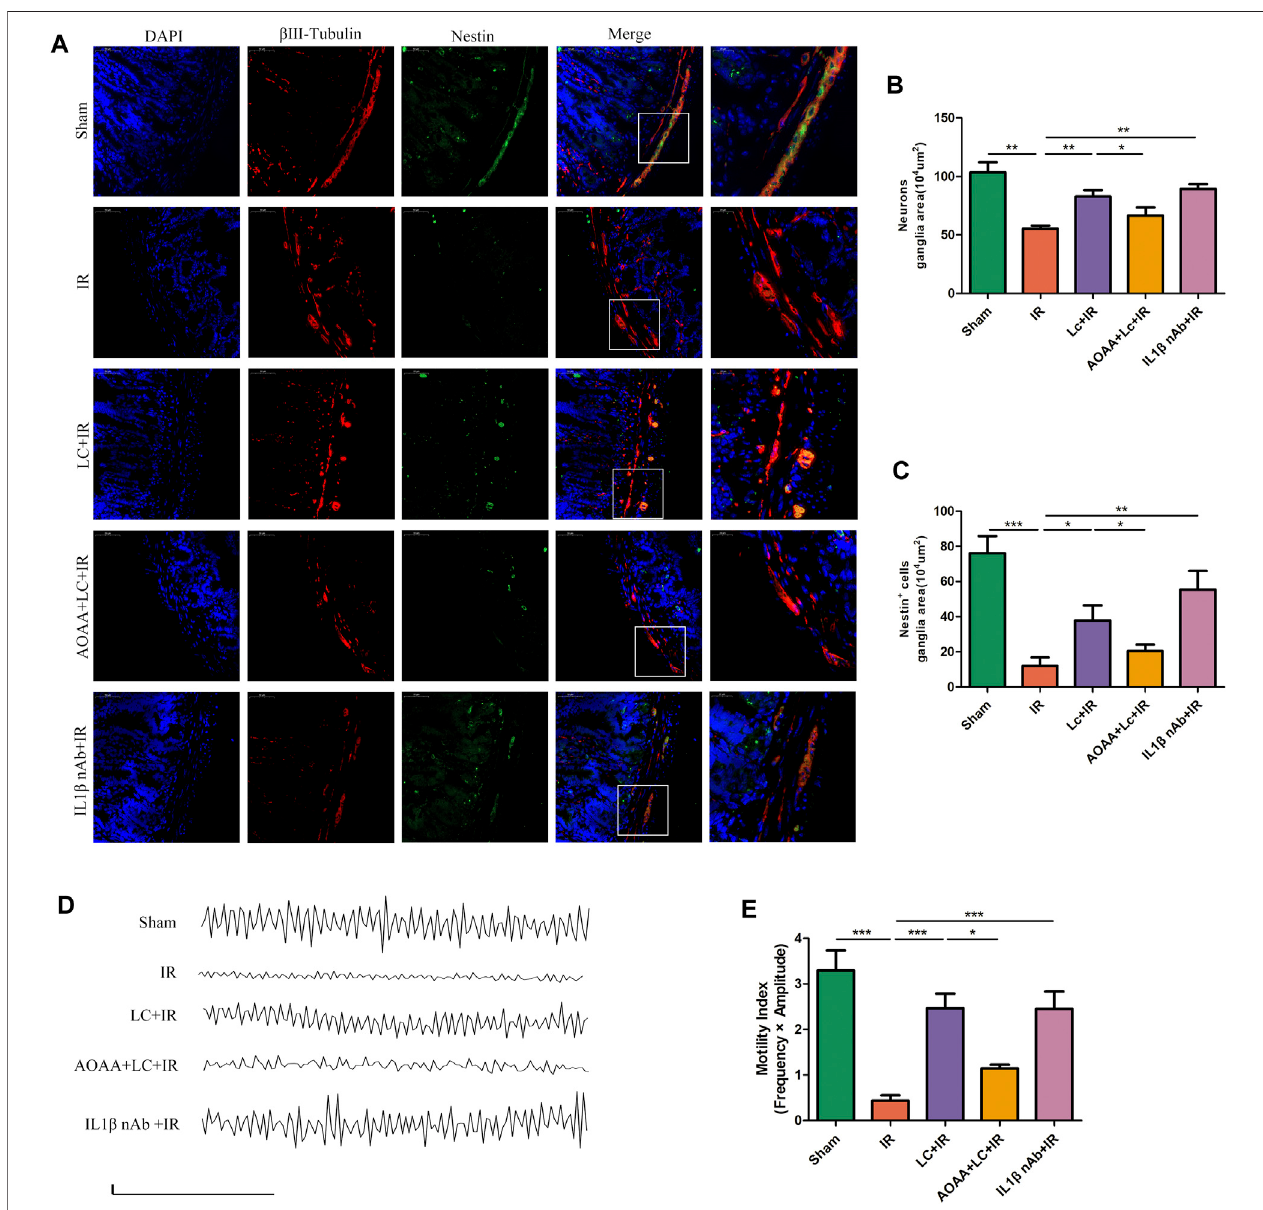
FIGURE 8 | L-Cys protected Nestin + ENPCs and improved intestinal contractile activity during IR. (A) Representative photographs of immuno fl uorescent staining of Nestin (green), β Ⅲ -tubulin (red), and DAPI (blue). Scale bar = 50 μ m. N = 4 /group. (B,C) Quantitative analyses of the number of neurons and Nestin + neurons in every 10 4 μ m 2 ganglion region Six randomly captured images per animal were analyzed for each group. N = 4 /group. (D) Basal spontaneous activity of longitudinal muscle contractionsfromthemousedistalileum(scalebars:0.05g,50s). N=5 /group. (E) Quantitativeanalysesofthemotilityindex. N=5 /group.Valuesare mean±SEM